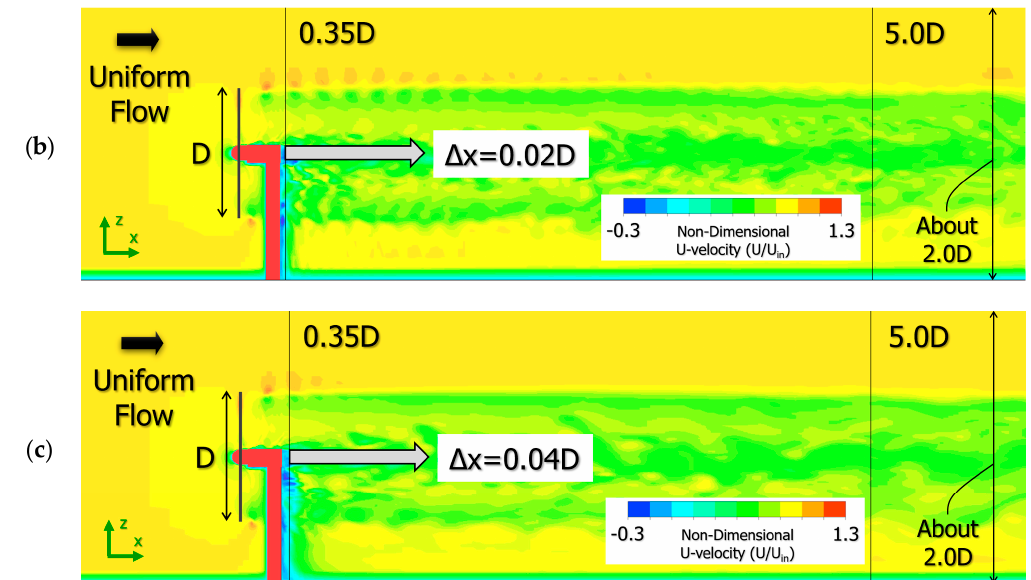
Figure A5. Spatial distribution of U-velocity for instantaneous flow field in the x–z plane (side view) at y = 0. The streamwise grid resolution downstream from x = 0.35 D is shown below: ( a ) ∆ x = 0.01 D, ( b ) ∆ x = 0.02 D, and ( c ) ∆ x = 0.04 D.